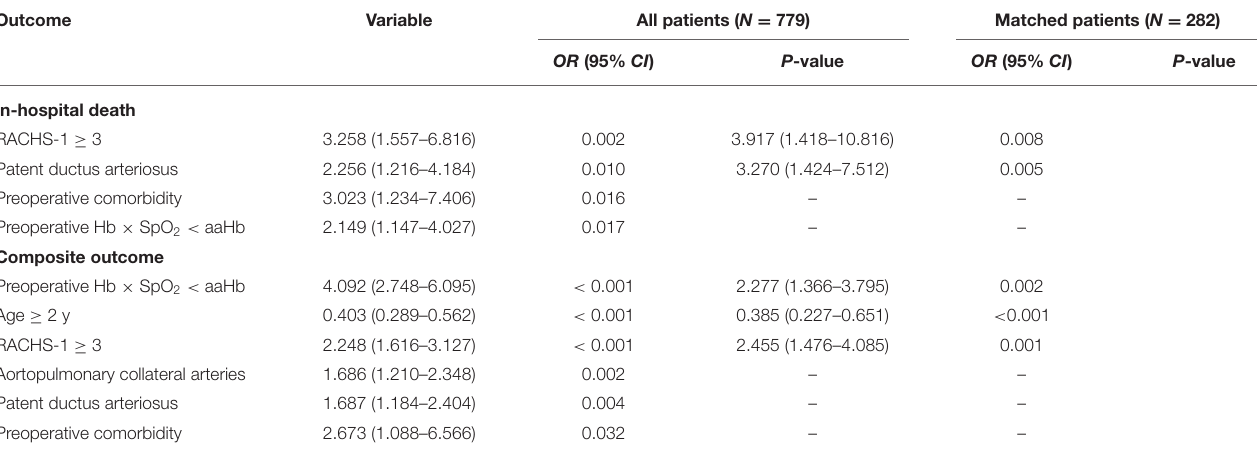
TABLE 3 | Multivariable analysis for the postoperative